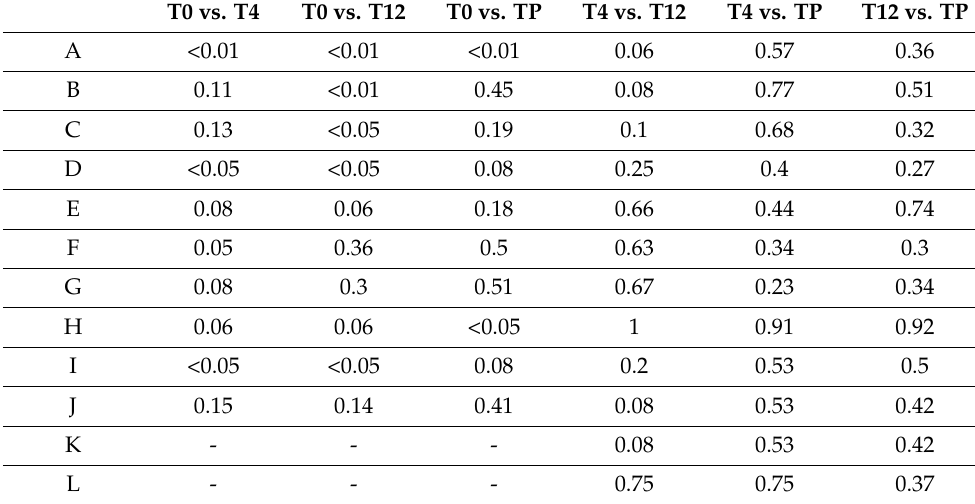
Table 2. Comparative results between variables 0 (prior to surgery), 4 and 12 months after surgery, and at the end of the study. T0 vs. T4 T0 vs. T12 T0 vs. TP T4 vs. T12 T4 vs. TP T12 vs.